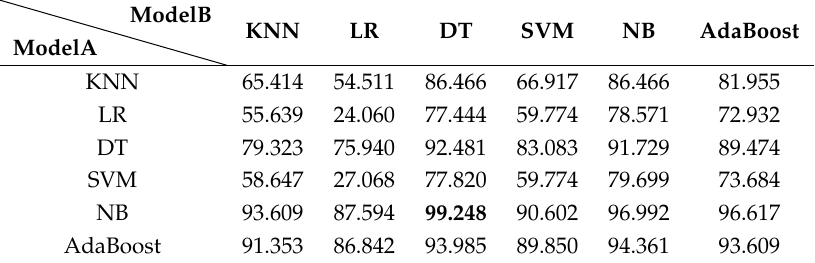
Table 5. The TPR (%) achieved by different combinations of Model A and Model B.